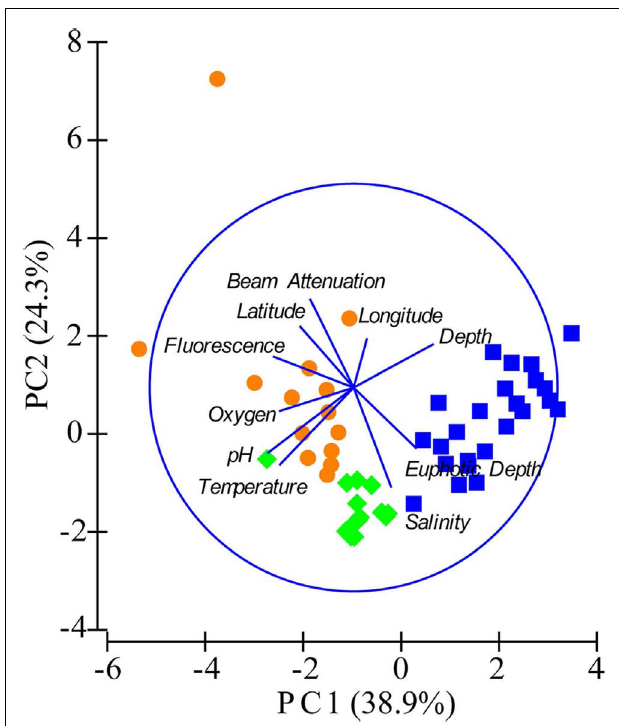
FIGUREA3 | Principal components analysis (PCA) of samples using environmental variables. Fluorescence, relative fluorescence, chlorophylla equivalents; beam attenuation, turbidity. Samples are shown as symbols representing three groupings based on depth and location: orange circles = near-surface inshore ( ≤ 100m depth, over the continental shelf), green diamonds = near-surface offshore ( ≤ 100m depth, shelf break and beyond), and blue squares = deep offshore ( > 100m, shelf break and